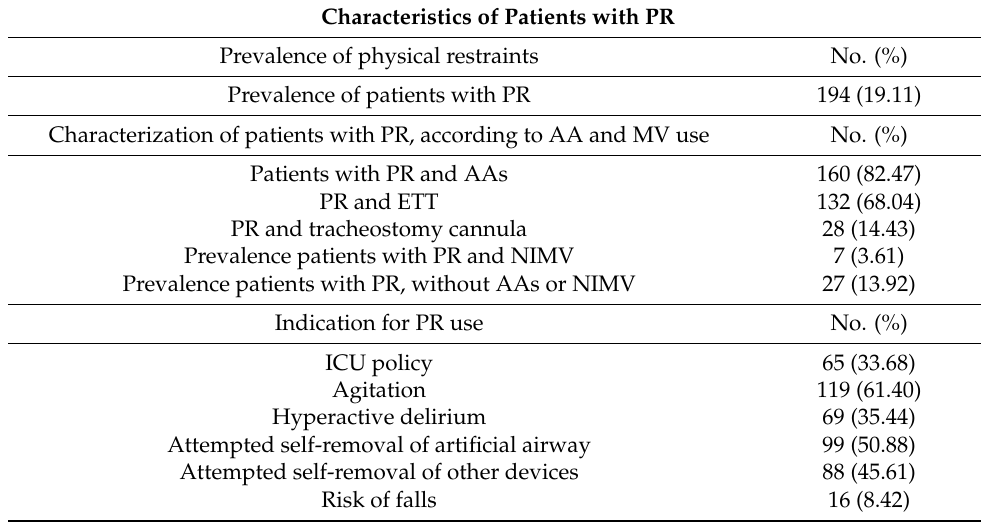
Table 8. General characteristics of patients WITH physical restraints observed in the clinical audit stage. Characteristics of Patients with